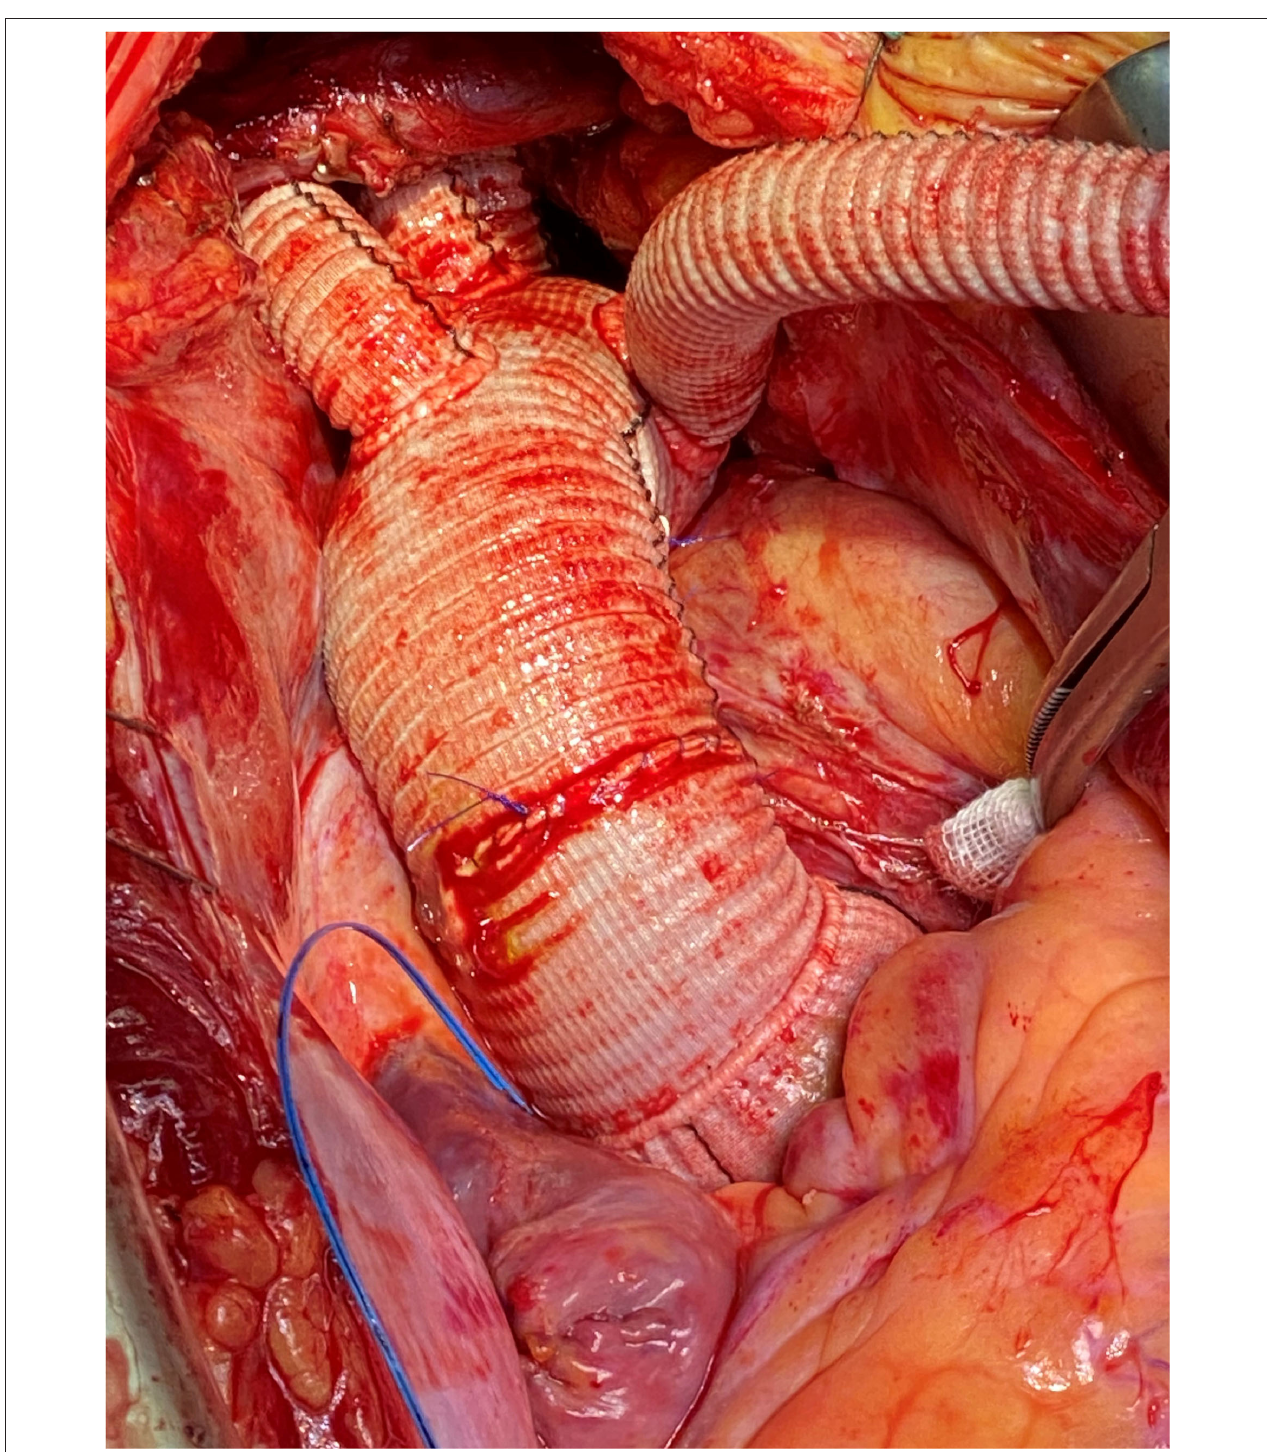
FIGURE 1 | Intraoperative photography, complete implantation of the Thoraflex Hybrid prosthesis with mechanical conduit.